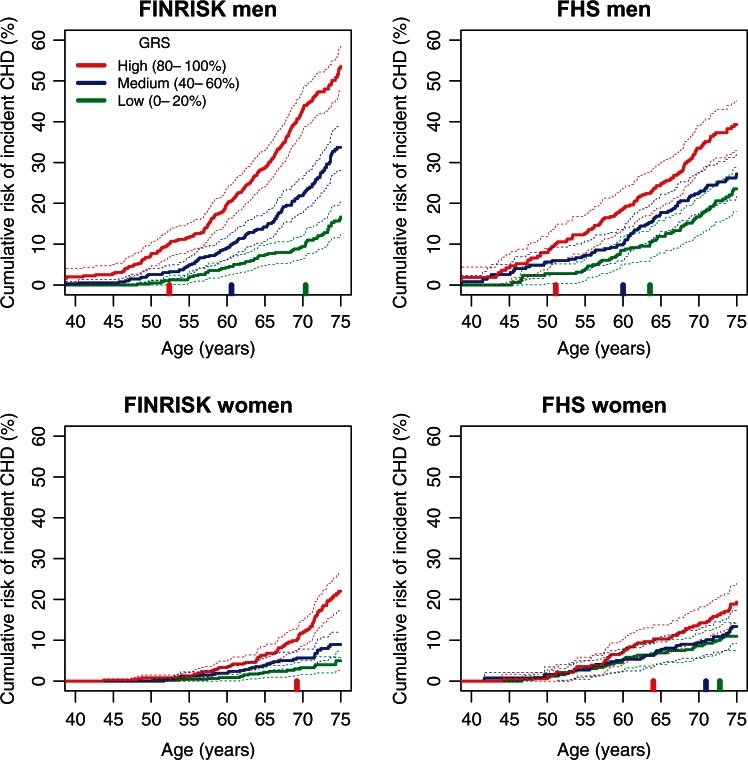
Kaplan-Meier cumulative risk
of incident CHD event by genomic risk group for men and women in the
FINRISK and FHS cohorts. Showing the cumulative risk in quintiles 0–20%,
40–60%, 80–100%. The vertical bars along the x-axis indicate the age at
which each risk group attains a cumulative CHD risk of 10%. Dashed lines
indicate 95% CI.